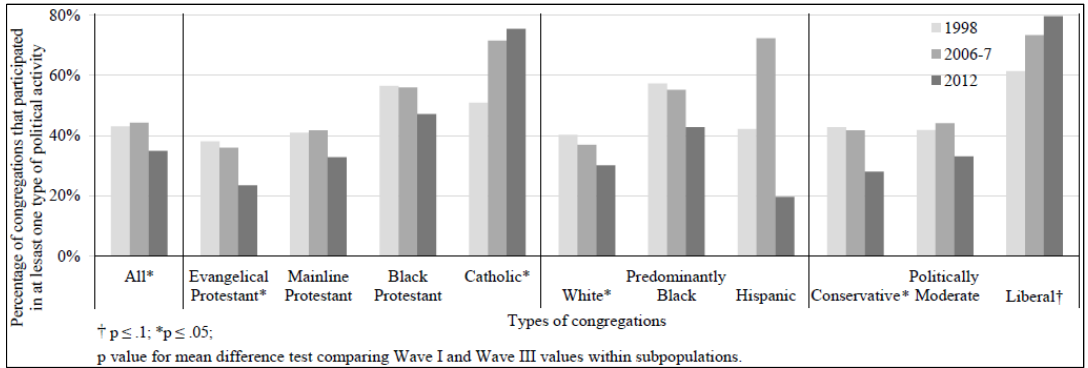
Figure 4. The percentage of congregations by subpopulation that participated in at least one type of political activity by wave.